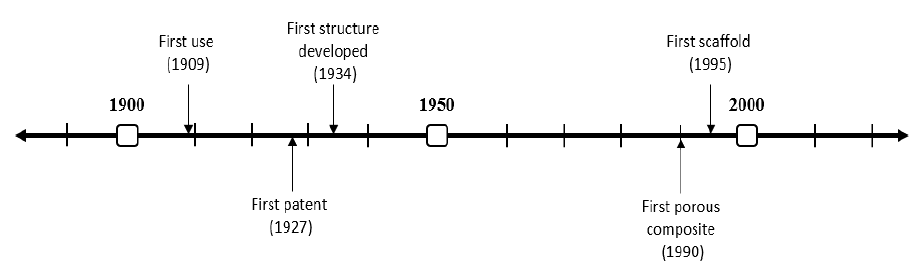
Figure 1. Timeline of the evolution of freeze-drying over history.